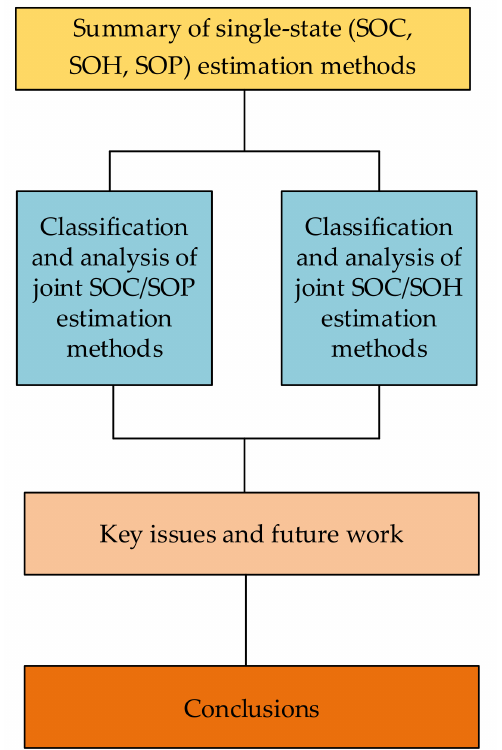
Figure 2. The structure of this